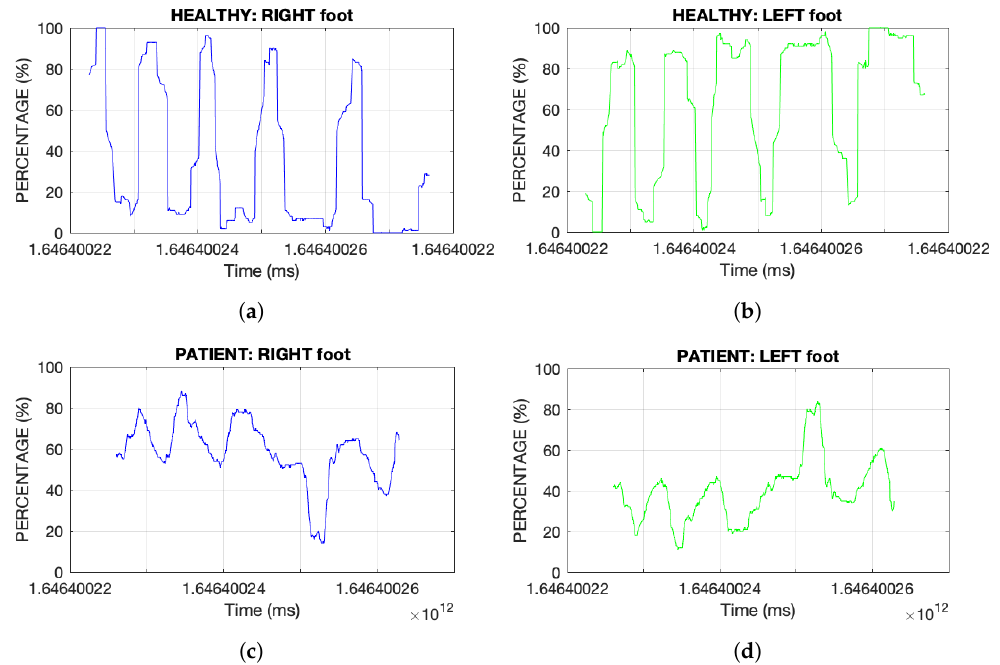
Figure 17. Example of pressure distribution on the same test between ( a , b ) a healthy tester and ( c , d ) a patient with right and left foot,